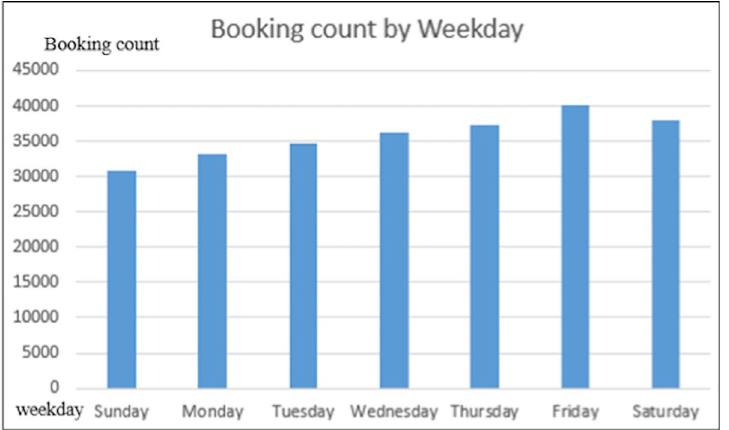
Fig 4. Number of bookings for weekday and